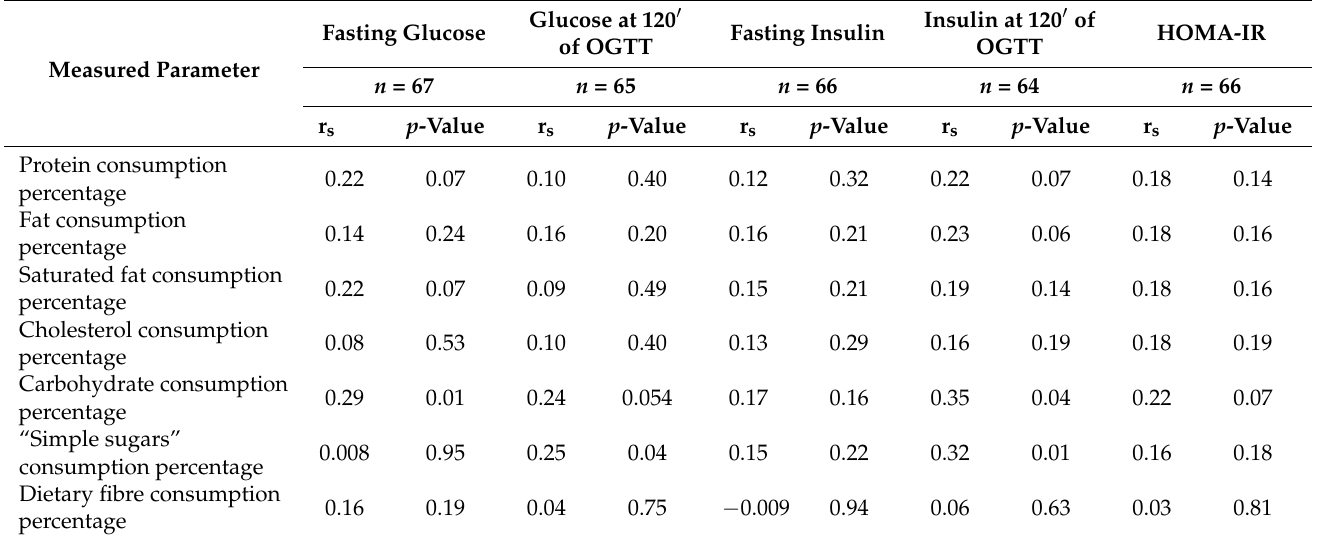
Table 8. Correlations between macronutrient consumption and measured glucose metabolism parameters in children after dietary